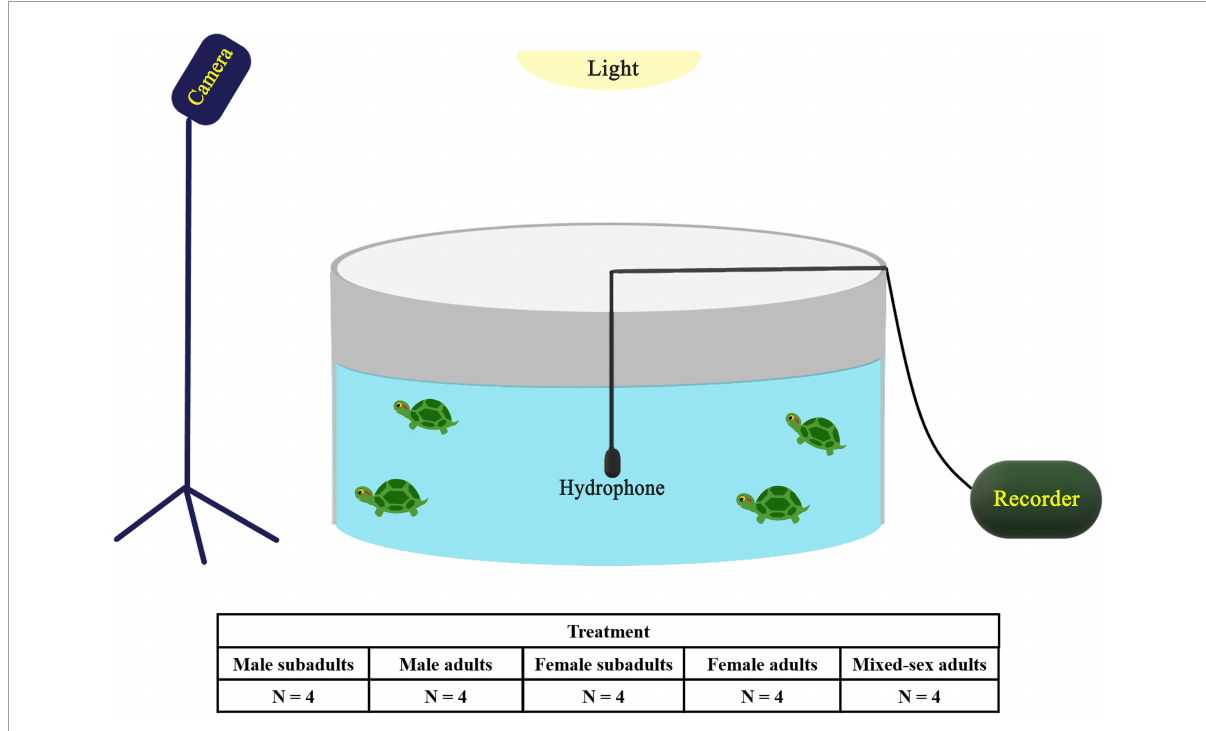
FIGURE1 Schematic of the recording for Trachemys scripta elegans in a soundproof room.